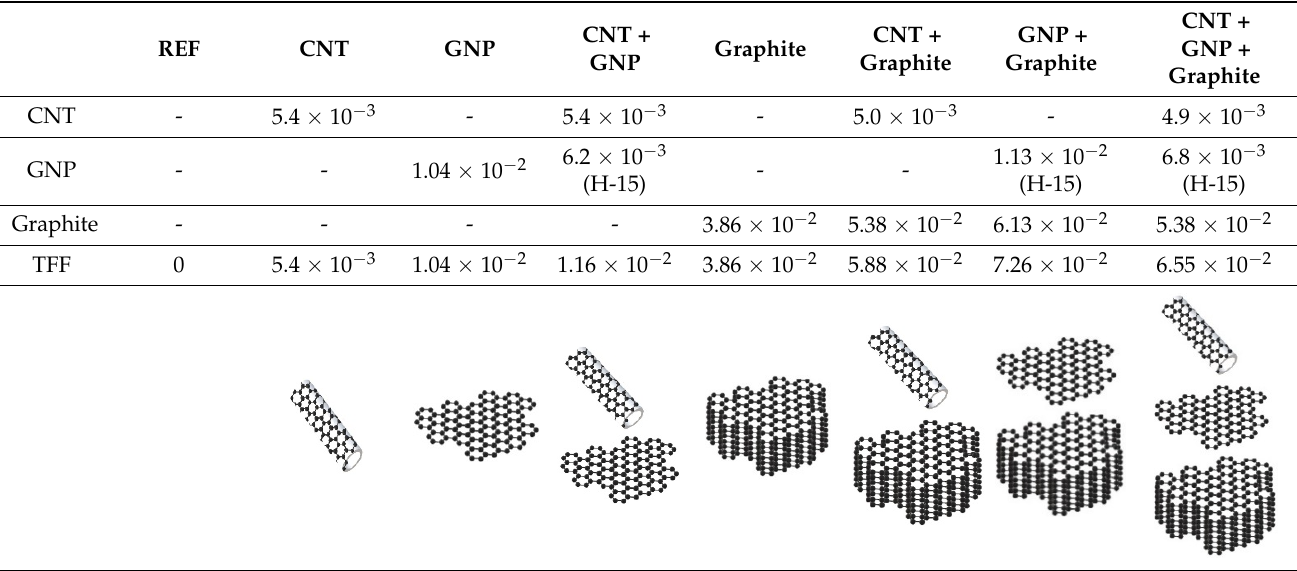
tion. At the top-view (Figure 2b), GNP and graphite are imaged face-on and perpendicular to the compression axis (see schematics). to the compression axis (see schematics).